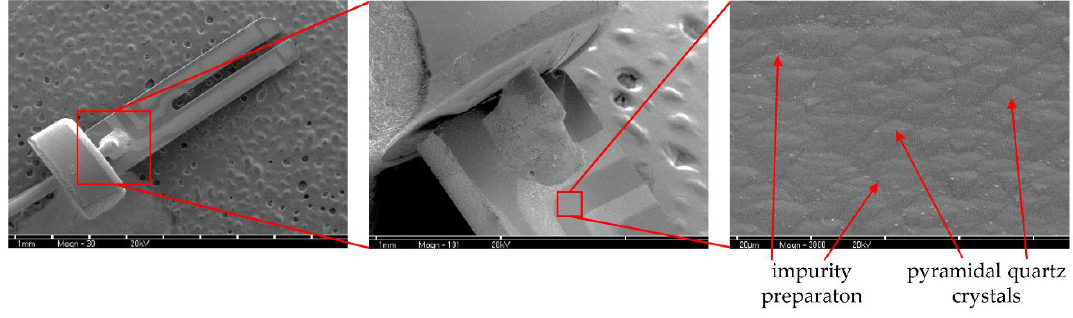
Figure 4. Visualization of QTF sensor surface immersed in TSB medium (without bacterial cells) at magnifications of 30× (left part) 100× (middle) and 3000× (right part), respectively.